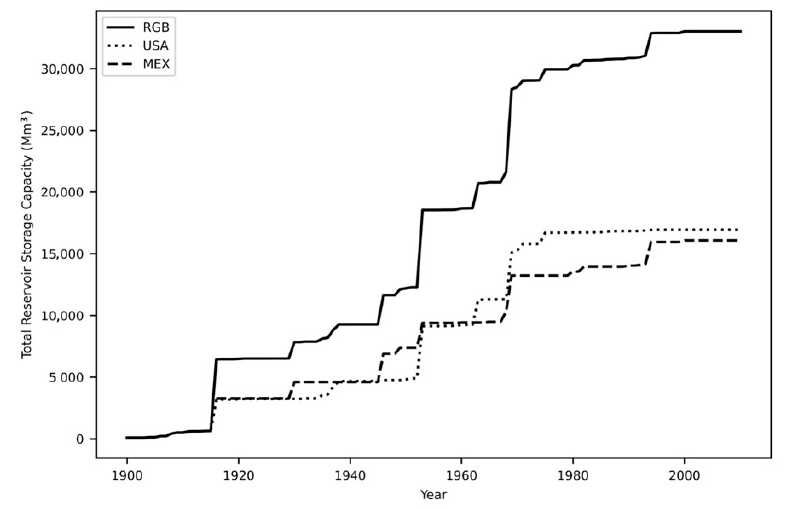
Figure 4. Total reservoir storage capacity (mm 3 ) in the Rio Grande–Bravo Basin (33,037 mm 3 ) and the portions of the United States (16,948 mm 3 ) and Mexico (16,089 mm 3 ).